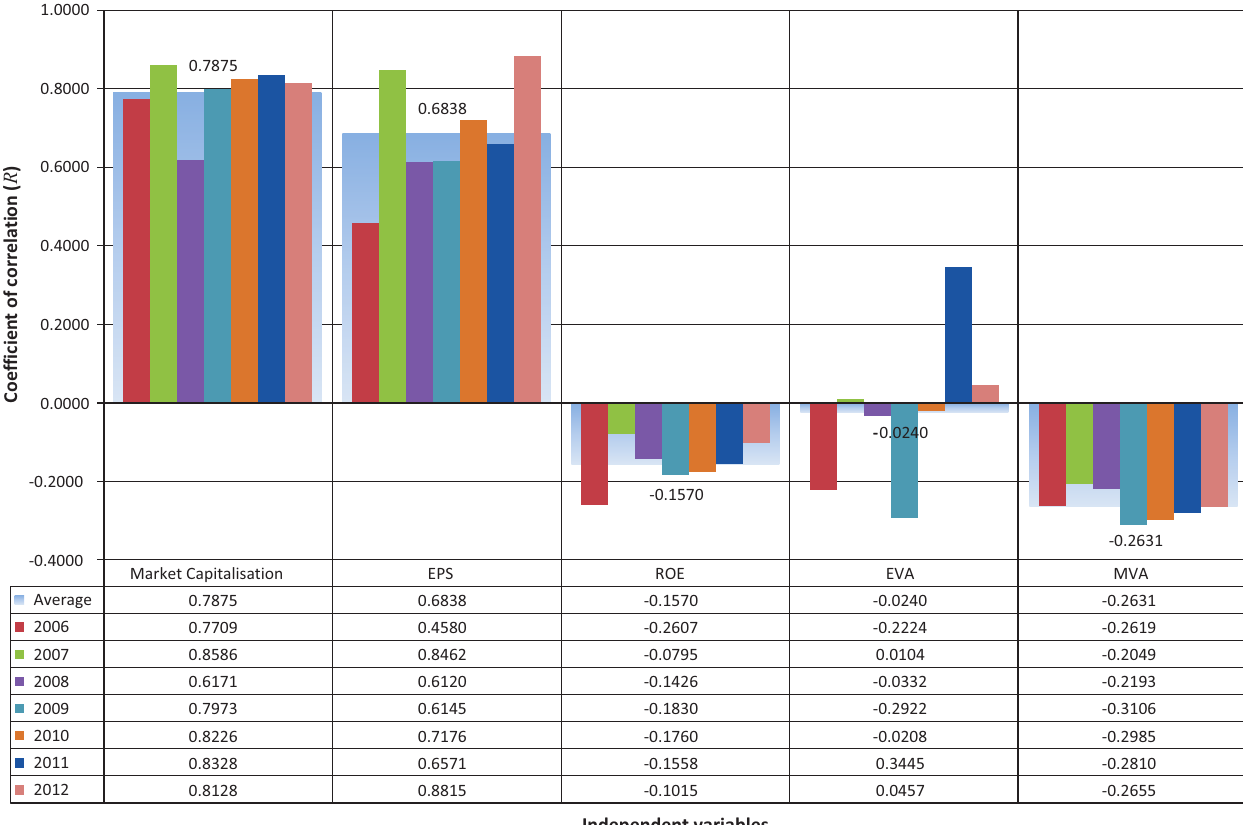
FIGURE 7: Correlation analysis: Fixed pay and organisational performance